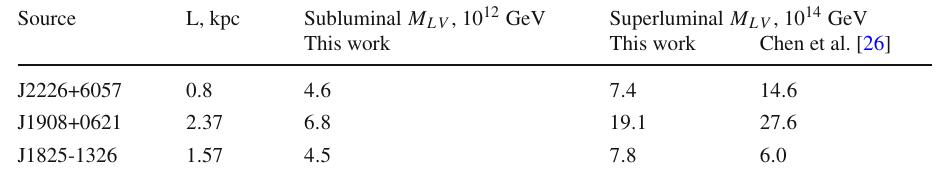
Fig. 2 The galactic source spectra measured by LHAASO (data points), the power-law fit for the spectra (green solid curve), the pre- dicted flux under superluminal (blue dashed curve) and subluminal